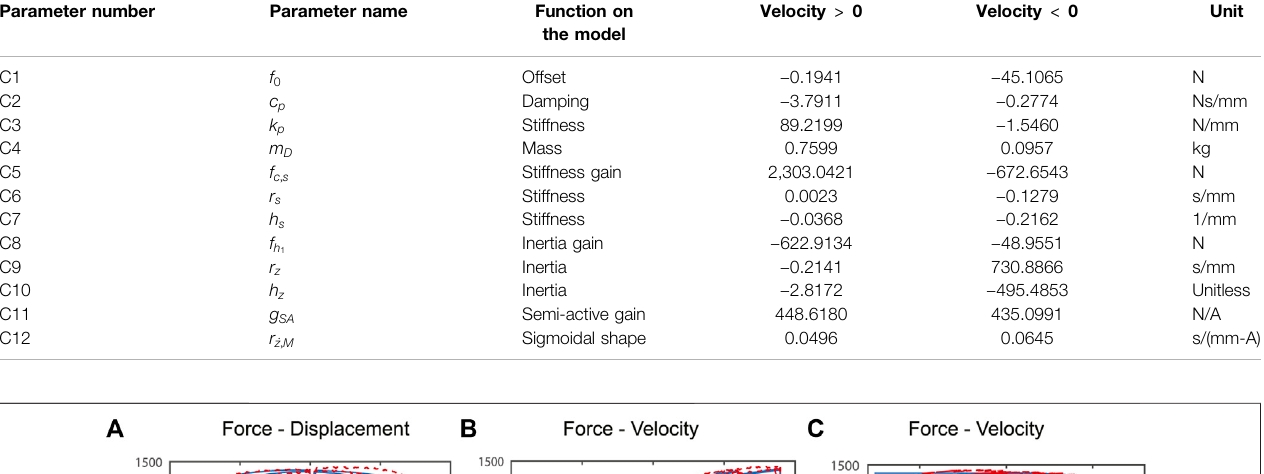
TABLE 15 | Identi fi ed model parameters for the Complete-Complete approach.